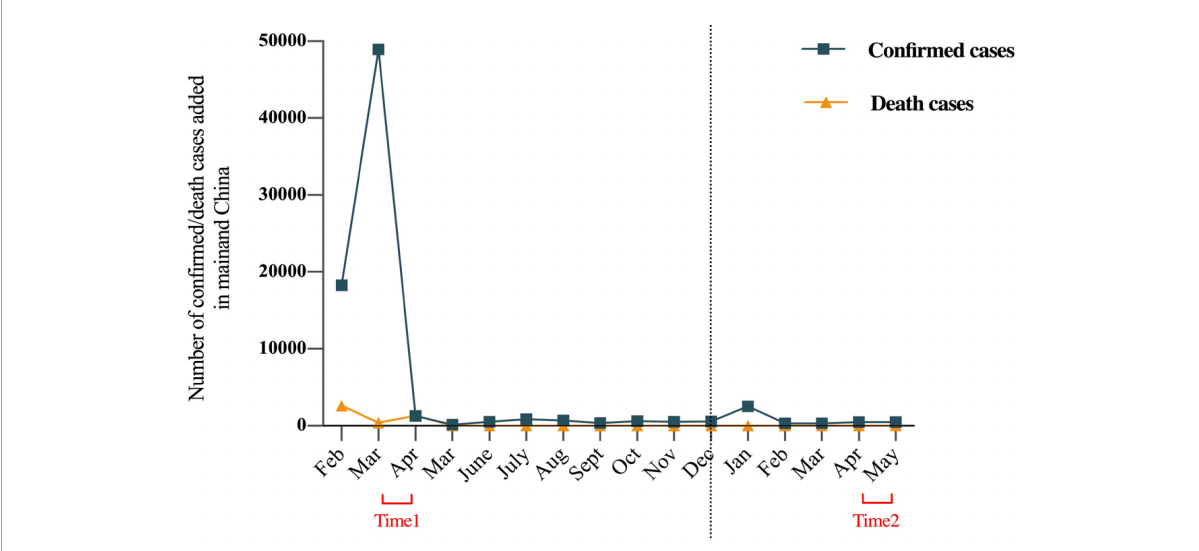
FIGURE1 Trajectory of the COVID-19 in mainland China with the number of confirmed and deaths cases added each month from February 2020 to May 2021. The left side of the dotted line is 2020, and the right side is 2021.